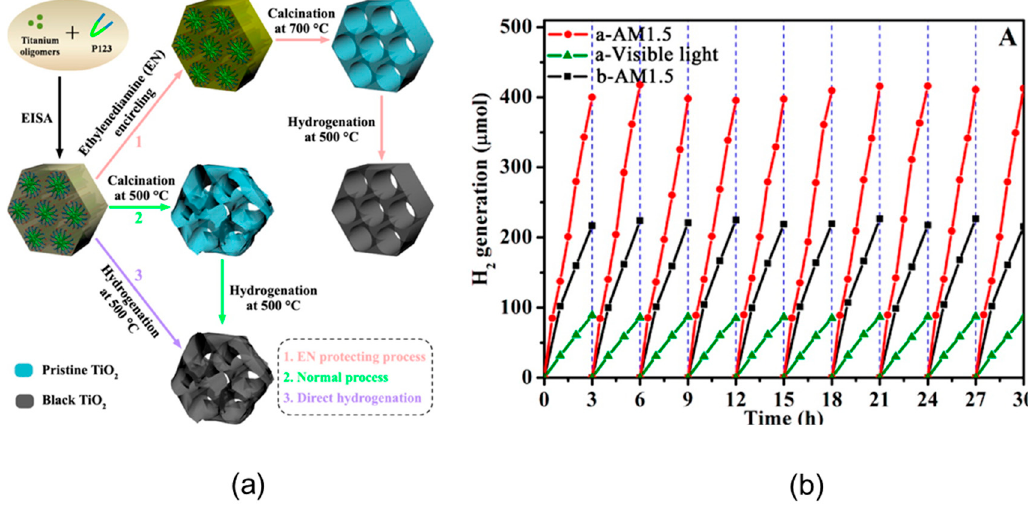
Figure 7. ( a ) The synthesis process of mesoporous black TiO 2 (OMBT). ( b ) Photocatalytic hydrogen production cycle experiment under AM 1.5 and visible light irradiation. Reprinted with permission from [141].